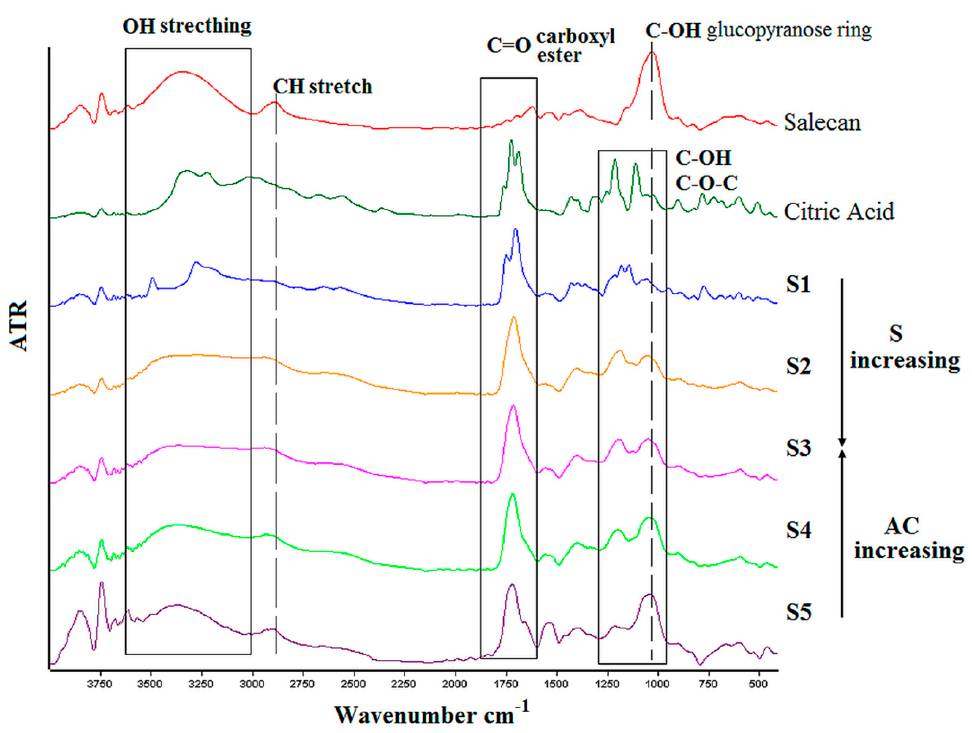
Figure 4. FTIR spectra of the crosslinked citrate-salecan samples.